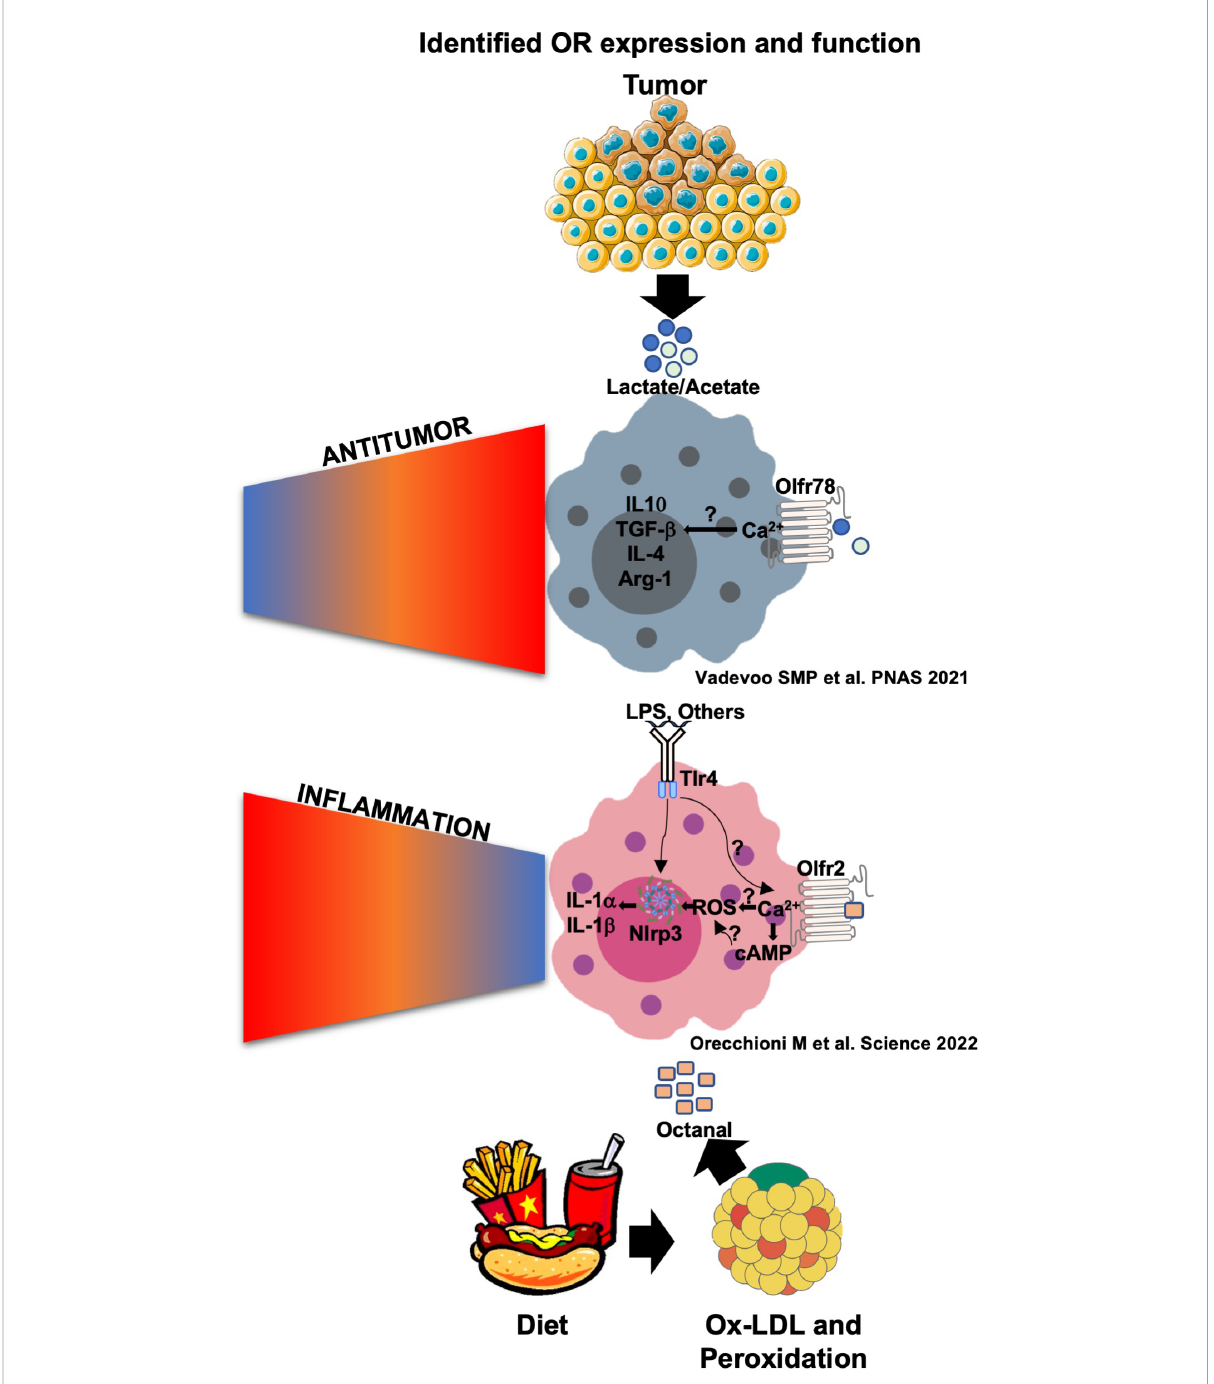
FIGURE 3 Olfr78 and Olfr2 signaling and function in response to their ligands in macrophages. Olfr78 has been reported to mediate the upregulation of the mRNA levels of M2-like cytokines such as IL-4, IL-10, TGF- b , and Arg1 in response to lactate that is highly abundant in the tumor microenvironment. This promotes immunosuppressive functions and tumor progression. Olfr78 signaling mechanisms in macrophages remain unknown. Olfr2 is ligated by octanal, which is likely derived from lipid peroxidation. Oxidized low-density lipoprotein (oxLDL) contains enough octanal to activate Olfr2, and this activation is gone in Olfr2 knockout macrophages. Olfr2 ligation mediates an increase in cAMP, which activates CNG-type calcium channels. The resulting Ca 2+ in fl ux causes increased reactive oxygen species (ROS), which serve as signal 2 for NLRP3 in fl ammasome activation. Olfr2 ligation is proin fl ammatory and exacerbates